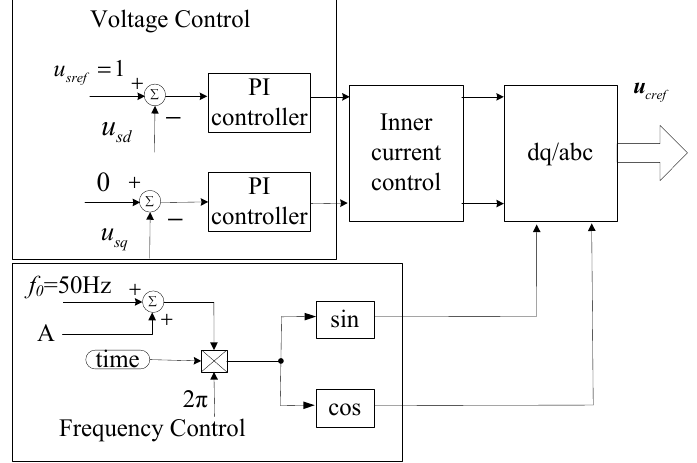
Figure 4. The constant voltage constant frequency (CVCF) control diagram of islanded voltage source converter (VSC) station.